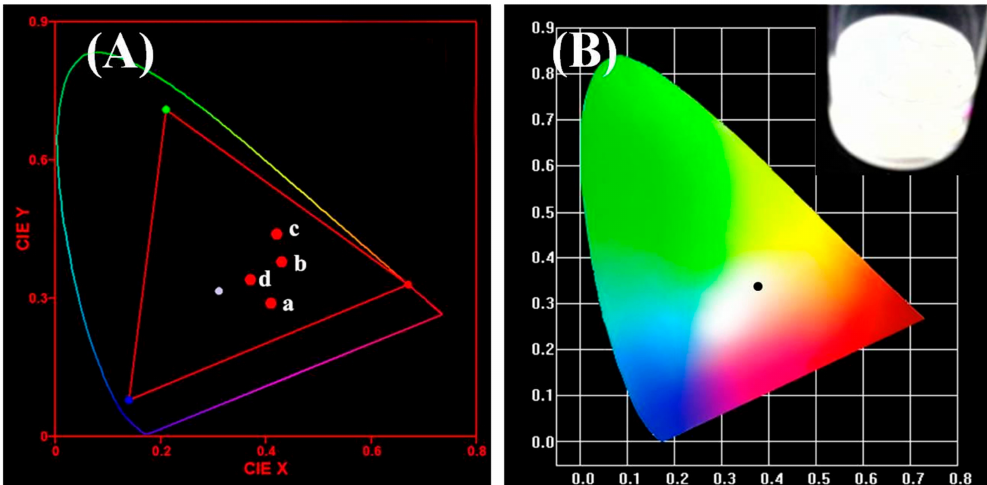
Figure 9. ( A ) CIE chromaticity diagram for CdSe / ZnS@P(MQ-co-St)-b-P(NIPAM-PVK) hybrid micelles with di ff erent micelles / QDs ratio (a = 1:0.5, b = 1:1, c = 1:3, d = 1:5) and ( B ) near-white light emission CIE with micelles / QDs ratio of 1:5.